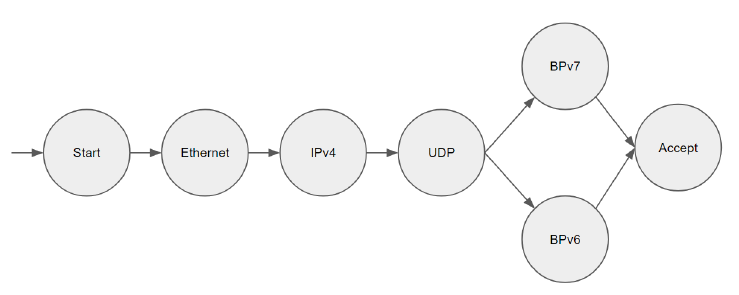
Figure 8. Parser state machine for Bundle Translator. The parser stage of a P4 program is coded as a series of states that are transitioned between using data from fields of the packet being